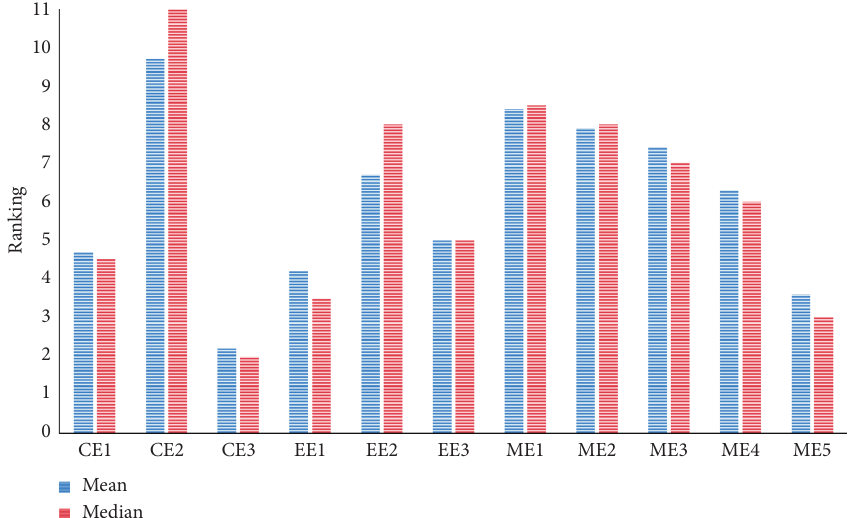
Figure 15: Peer-to-peer ranking